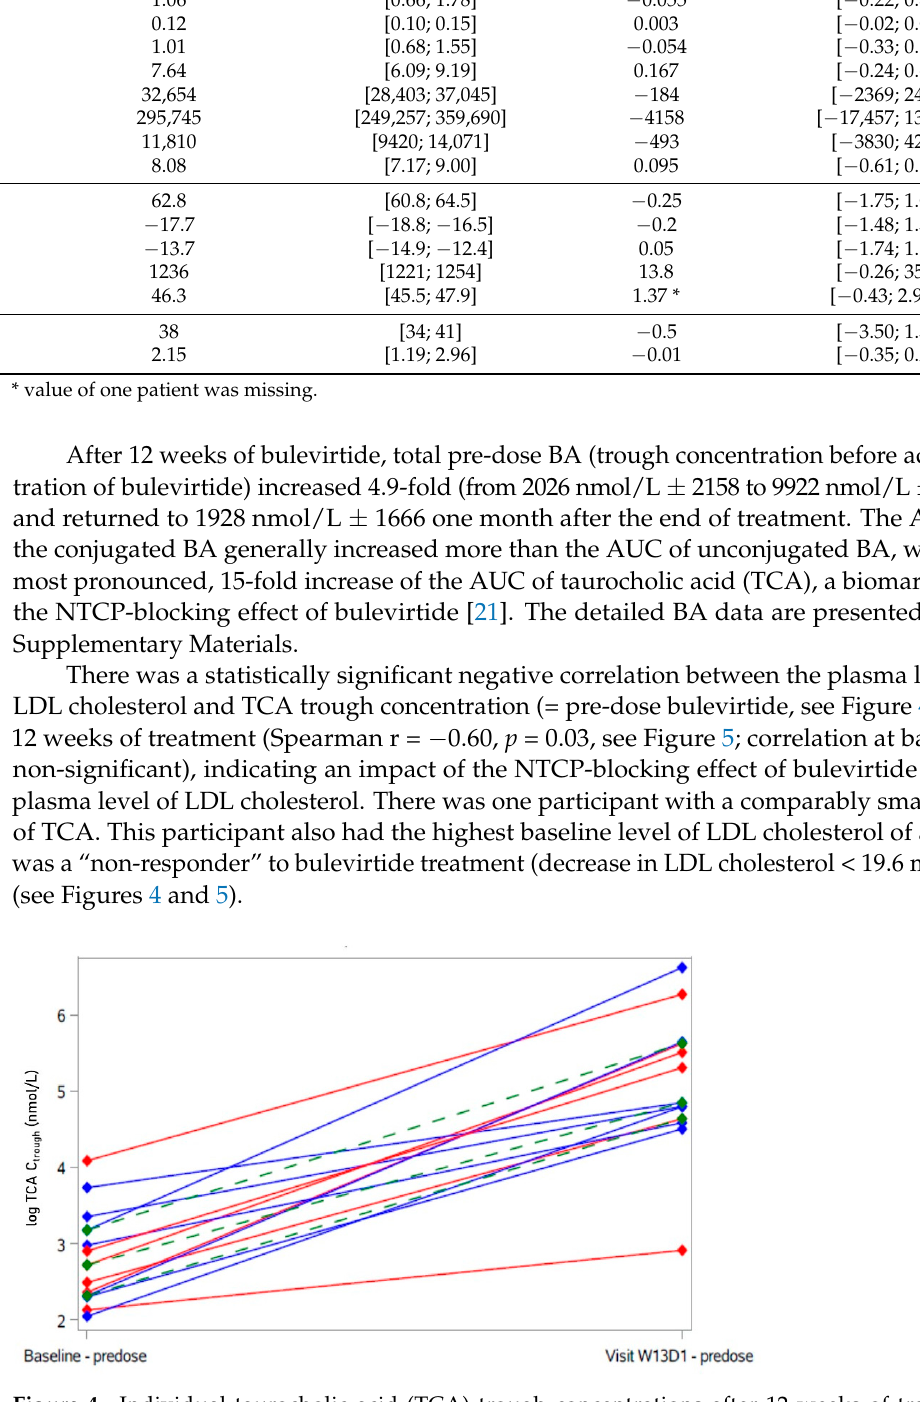
Figure 4. Individual taurocholic acid (TCA) trough concentrations after 12 weeks of treatment with bulevirtide. Participants with decrease of LDL cholesterol > 19.6 mg/dL in blue (“responder”); participants with no decrease and decrease < 19.6 mg/dL of LDL cholesterol in red (“non-responder”). Green: Hodges–Lehmann estimator with 95% confidence interval.